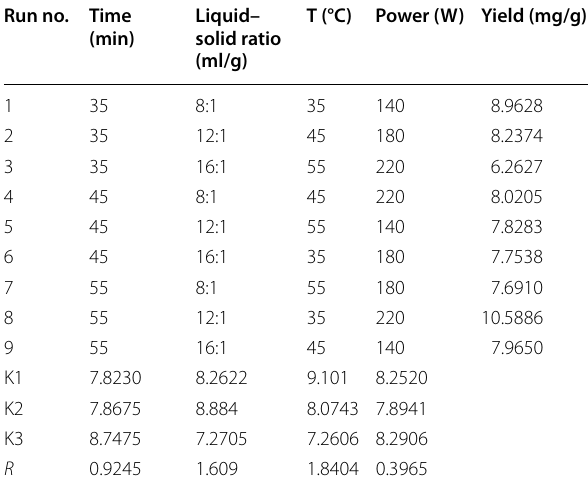
Table 3 Results of orthogonal test and range analysis